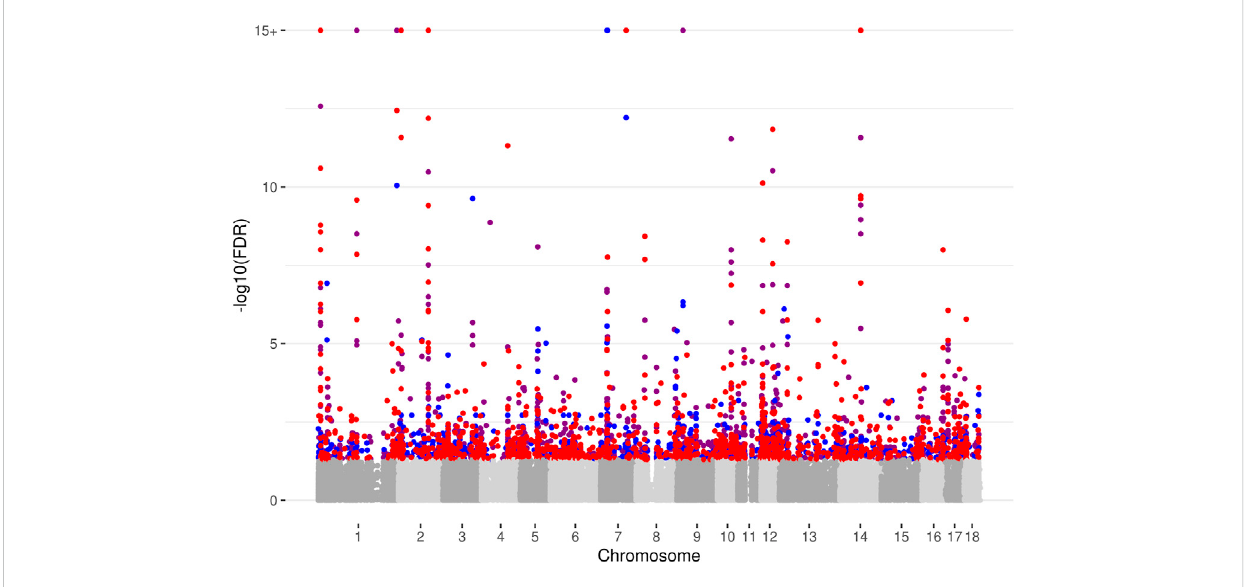
FIGURE 1 Manhattan plot depicting results of the analysis of conditional allele-speci fi c expression. Signi fi cant cd-ASE loci ( − log10 of Benjamini-Hochberg FDR > 1.3) are shown in red for LPS compared to Control (C vs. L), in blue for Dexamethasone compared to Control (C vs. D), and purple for LPS + Dexamethasone compared to Control (C vs. LD), respectively. Non-signi fi cant loci are shown in grey tones. Please note that the − log10(FDR) values are fl attened at − log10(FDR) =